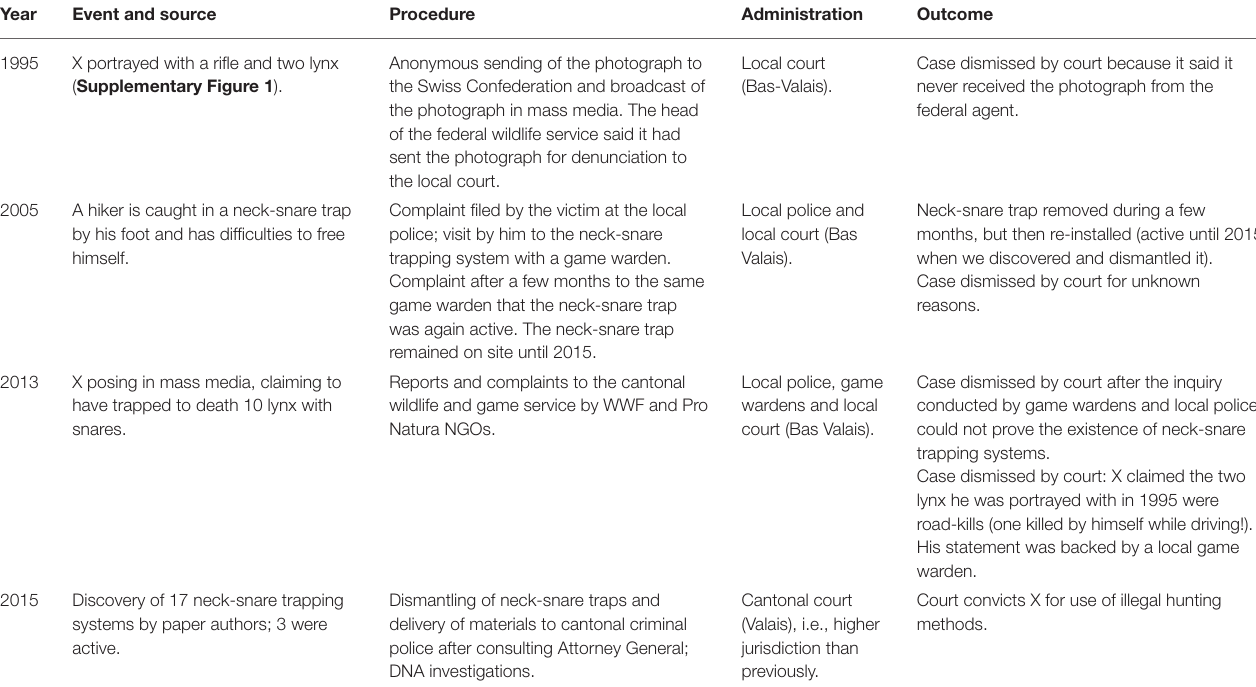
TABLE 5 | History of lynx poaching with neck-snare traps in Valais, southwestern Switzerland, based on media broadcast and justice decisions. Year Event and source 1995 X portrayed with a rifle and two lynx ( Supplementary Figure 1